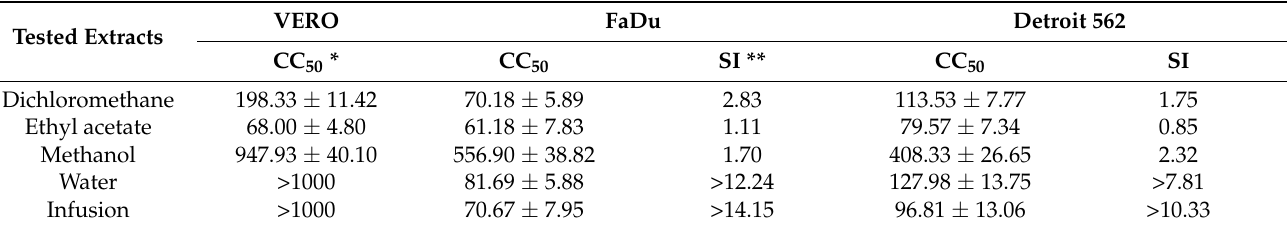
Table 4. Cytotoxicity of Justicia secunda extracts after 72 h